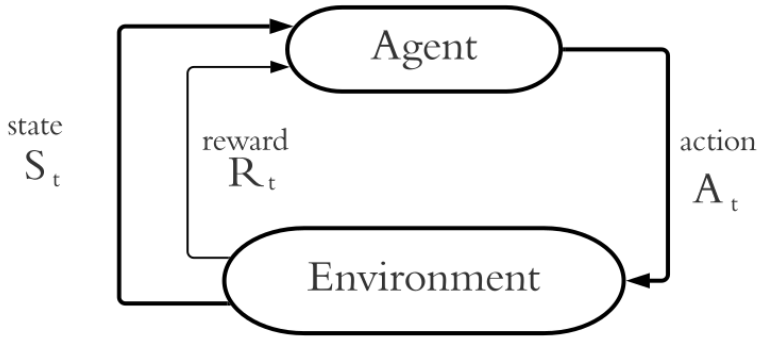
Figure 1. RL scheme and interactions [42].